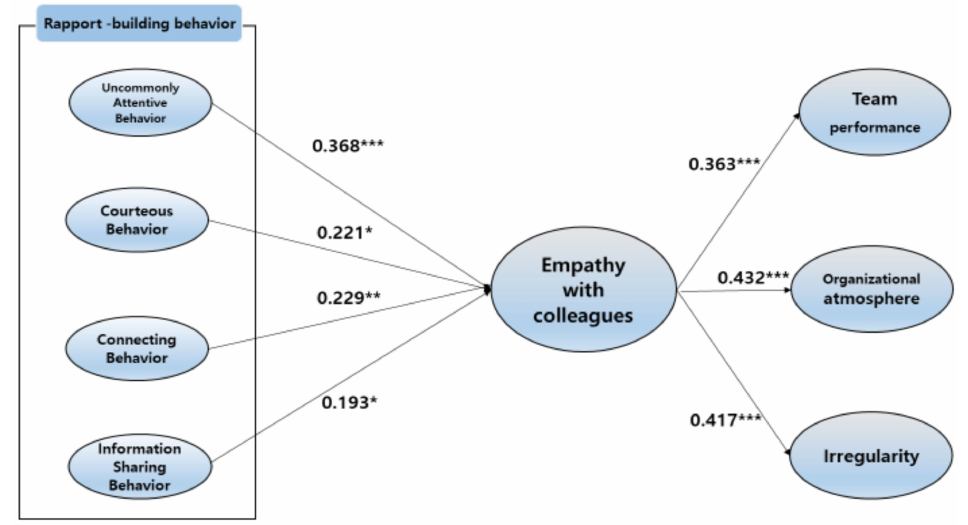
Figure 2. Results from the SEM model. (* p < 0.05, ** p < 0.01, *** p <